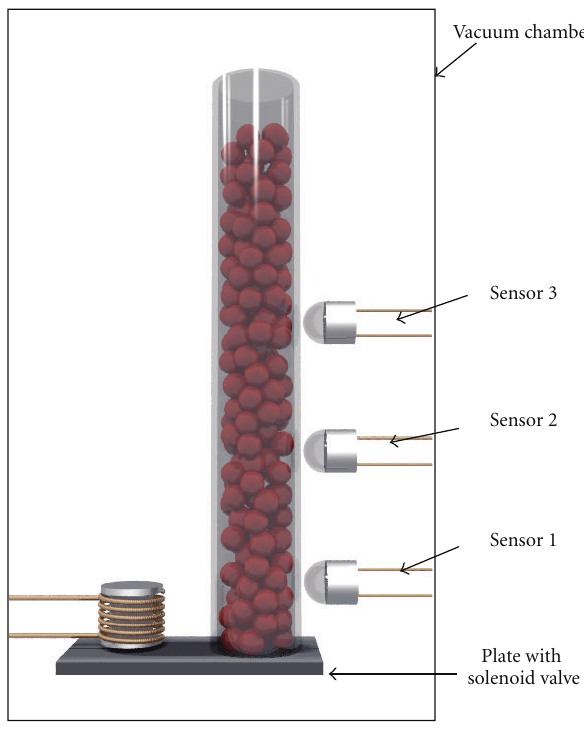
Figure 5: Schematic representation of the experiment.